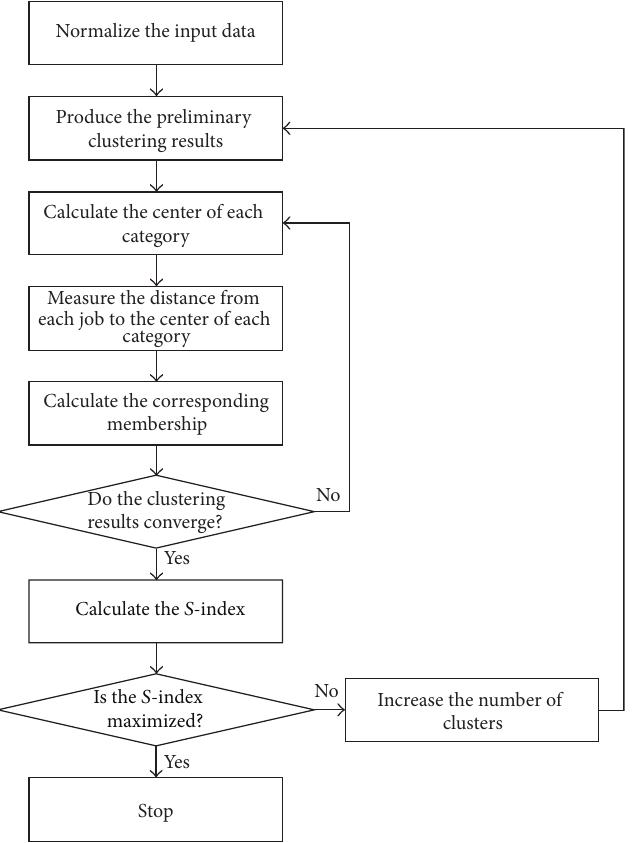
Figure 3: The FCM